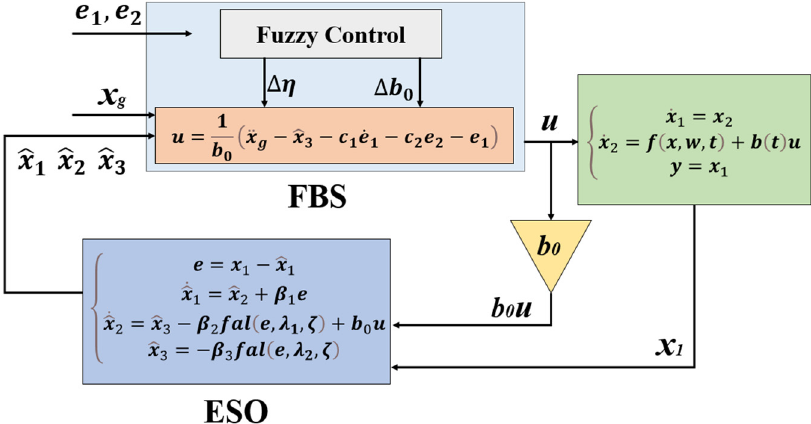
Figure 3. Block diagram of the FBS ‐ ESO controller.